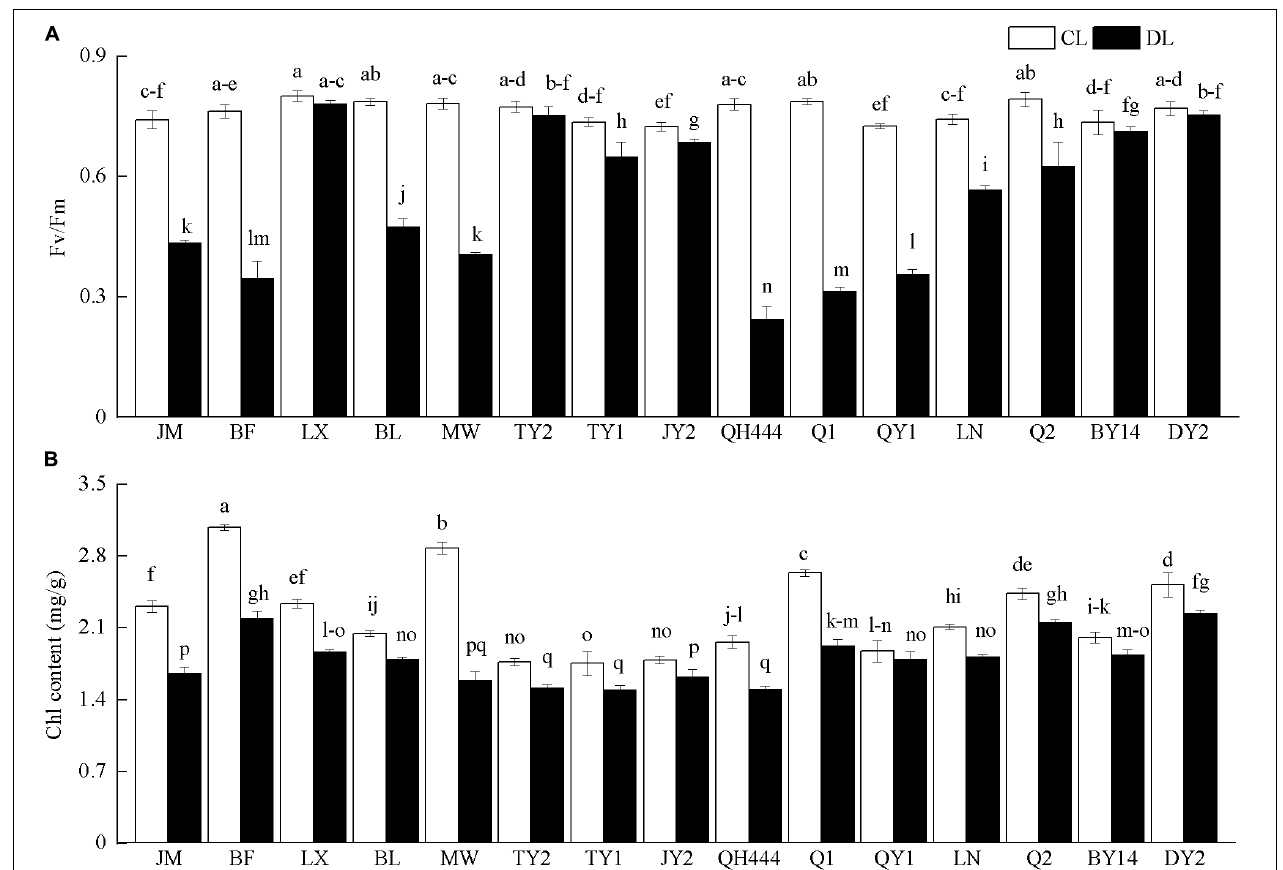
FIGURE 5 | Photochemical efficiency (Fv/Fm) (A) and chlorophyll content (B) in oat varieties under drought stress. Each value represents the mean ± SD. Each experiment was repeated three times. An analysis of variance test was performed, followed by Tukey test. CL, untreated control; DL, drought stress. Different letters indicate that the differences between treatments were significant ( P <